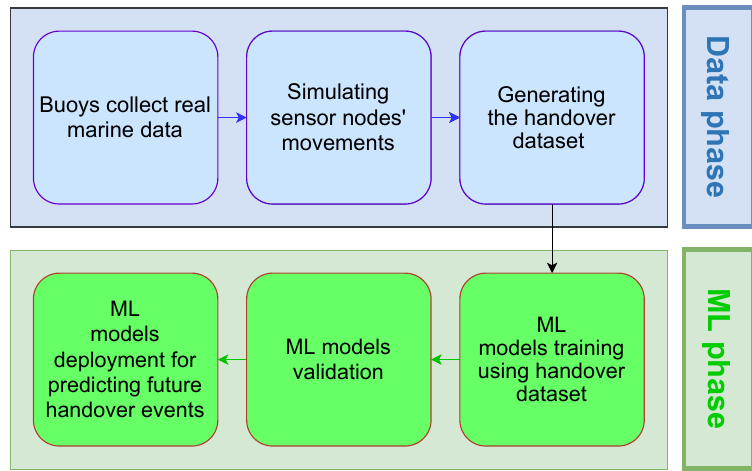
Figure 5. Block diagram of the proposed